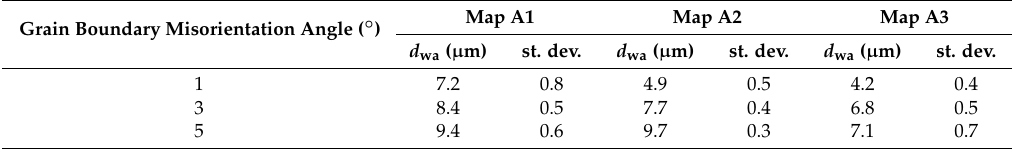
Figure 4. EBSD maps of transversal metallographic sections (belongs to a plane parallel to the forging axis) of samples deformed through up-setting before ageing at: room temperature ( a ), 423 K ( b ) and 473 K ( c ). Black grain boundaries highlight misorientation angles not lower than 5°. Table 3. Grain sizes calculated on the detected EBSD orientation maps depending on the adopted misorientation angles. The standard deviations are related to the grain size log-norm distribution in the map.